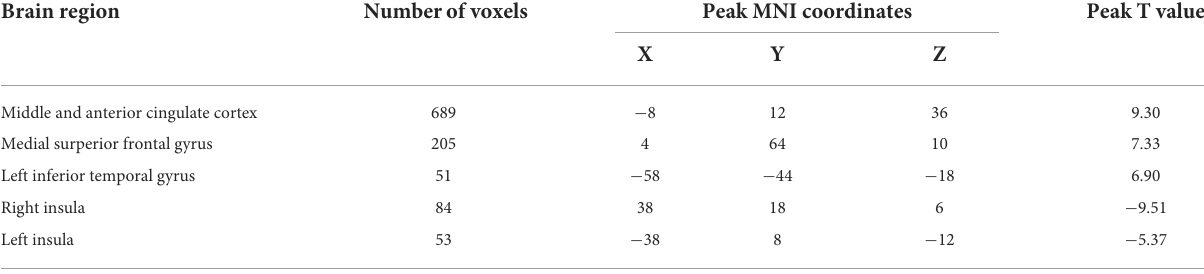
TABLE 2 Brain regions showing significant differences of the left hippocampus-based functional connectivity in patients with ruptured ACoA as compared to the healthy controls. Brain region Number of voxels Peak MNI coordinates Peak T value